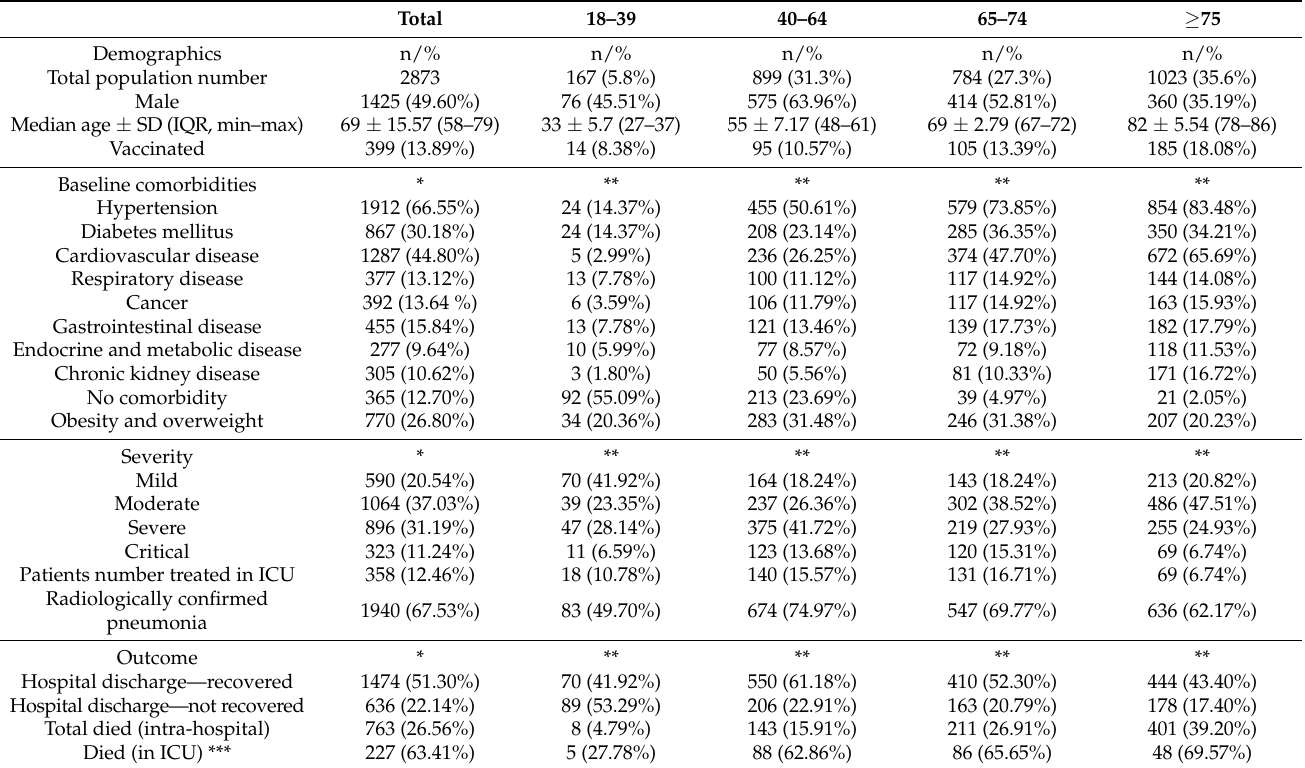
Table A1. Baseline characteristics, comorbidities, COVID-19 severity and outcomes according to age